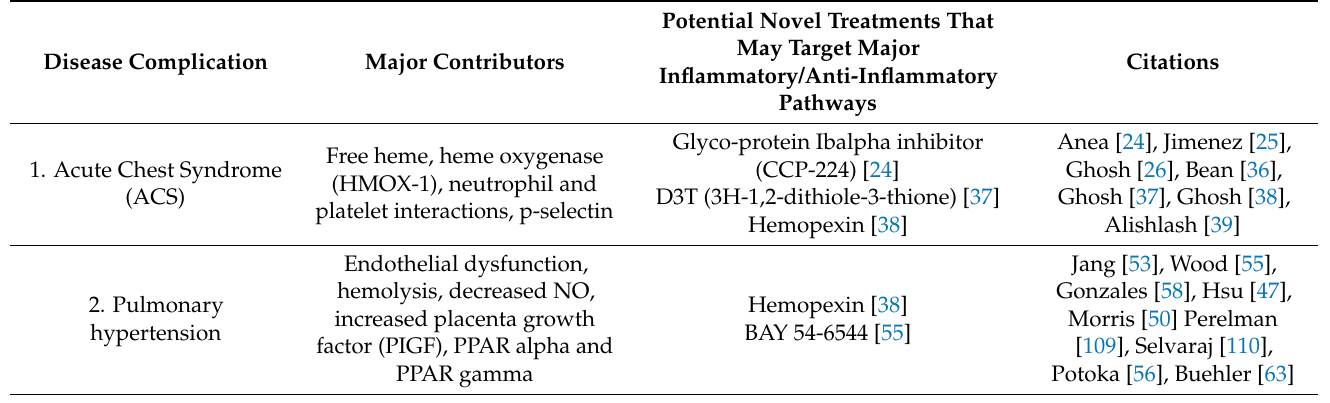
Table 1. Summary of inflammatory mediators and potential novel treatments in cardiopulmonary complications in sickle cell